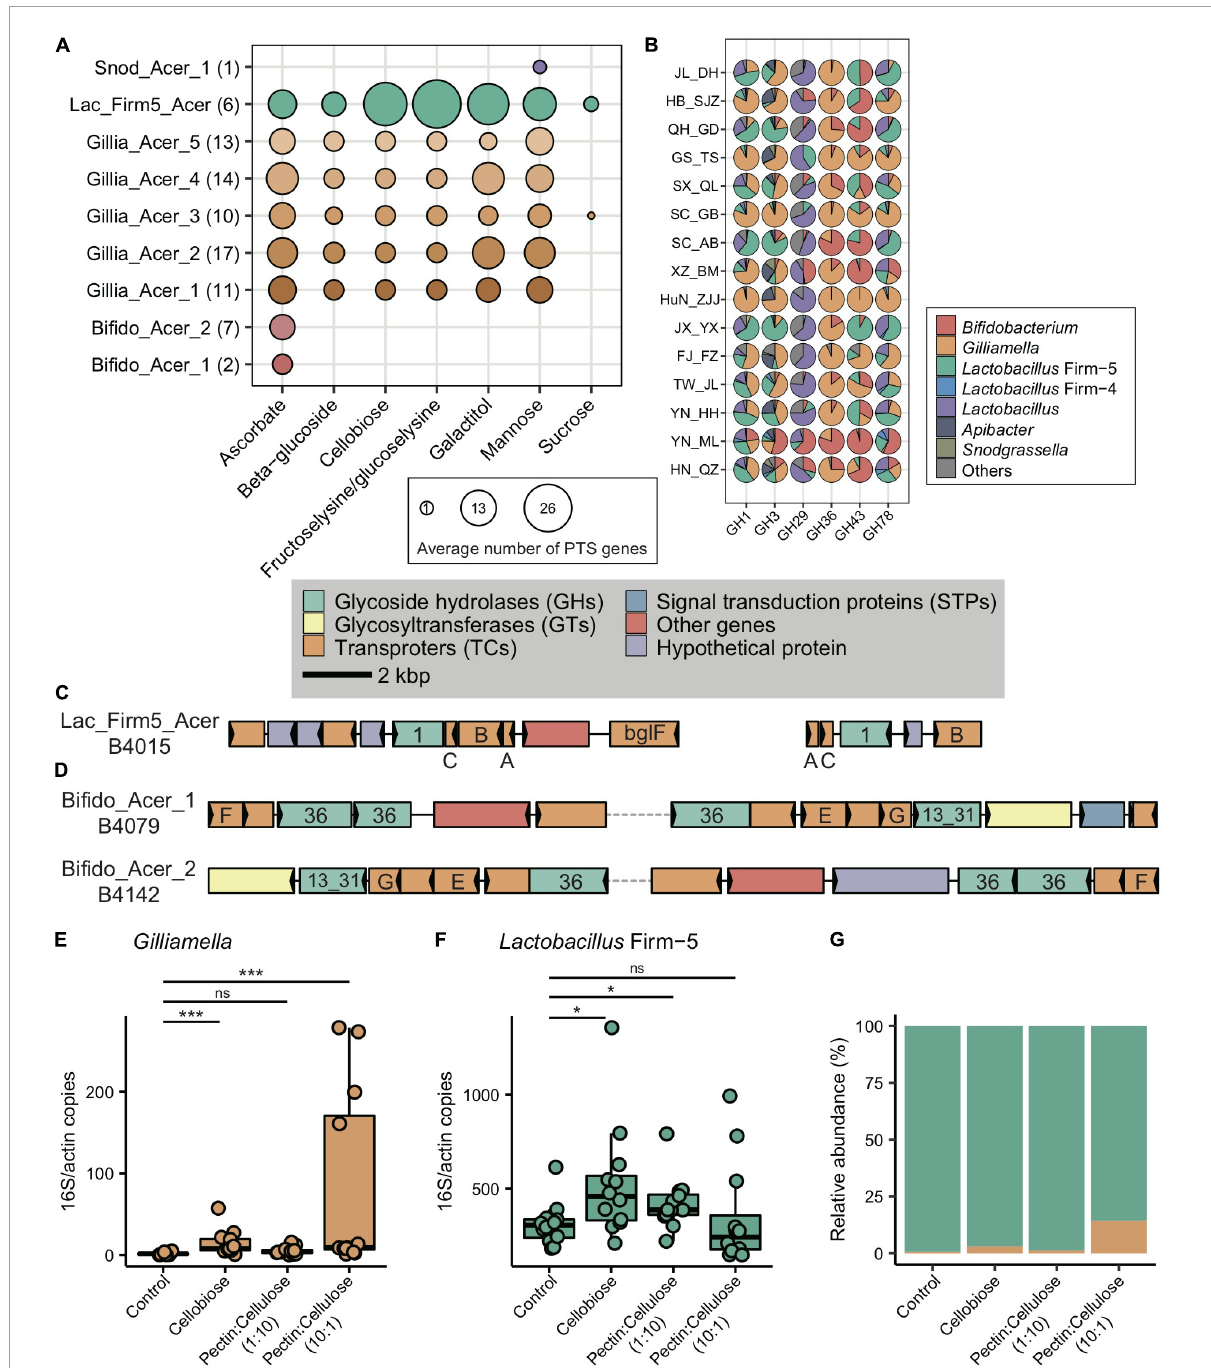
FIGURE5 Main bacterial phylotypes coding for PTS and GHs. (A) Gene copy numbers in population-featured PTS pathways identified in all SDPs. Numbers in parentheses represent SDP strain numbers. Genes were annotated from the genomes of newly isolated microbial strains from A. cerana guts. (B) Featured GHs were coded by different bacterial phylotypes from metagenome of 15 geographic populations of A. cerana . (C) PTS transporters ( celA / celB / celC / bglF ), 6-phospho-beta-glucosidase ( bglA ) from the GH1 family were often found located together in genomes, which were represented here by Lactobacillus Firm-5 SDP. (D) ABC transporters ( msmE / msmF / msmG ), alpha-galactosidase from the GH36 family, and alpha-glucosidase from the GH13_31 family were often found located together in genomes, which were represented here by two Bifidobacterium SDPs. The change in the absolute abundance of Gilliamella (E) , Lactobacillus Firm-5 (F) , and the percentage of Gilliamella and Lactobacillus Firm-5 (G) after feeding cellobiose and mixtures of pectin and cellulose with different concentrations. PTS, phosphotransferase system; GH, glycoside hydrolase. ns, not significantly different, * p < 0.05, *** p <